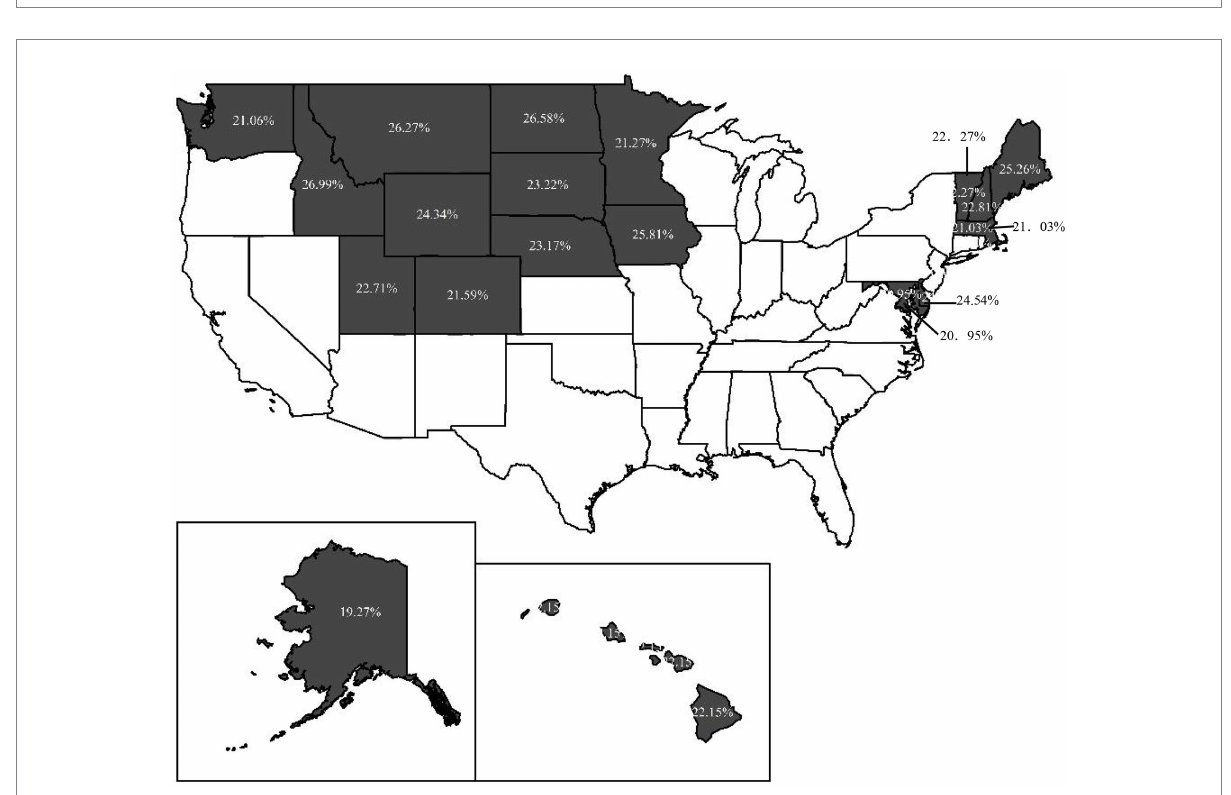
FIGURE 4 The distribution of the proportion of respondents with Y = 1 in